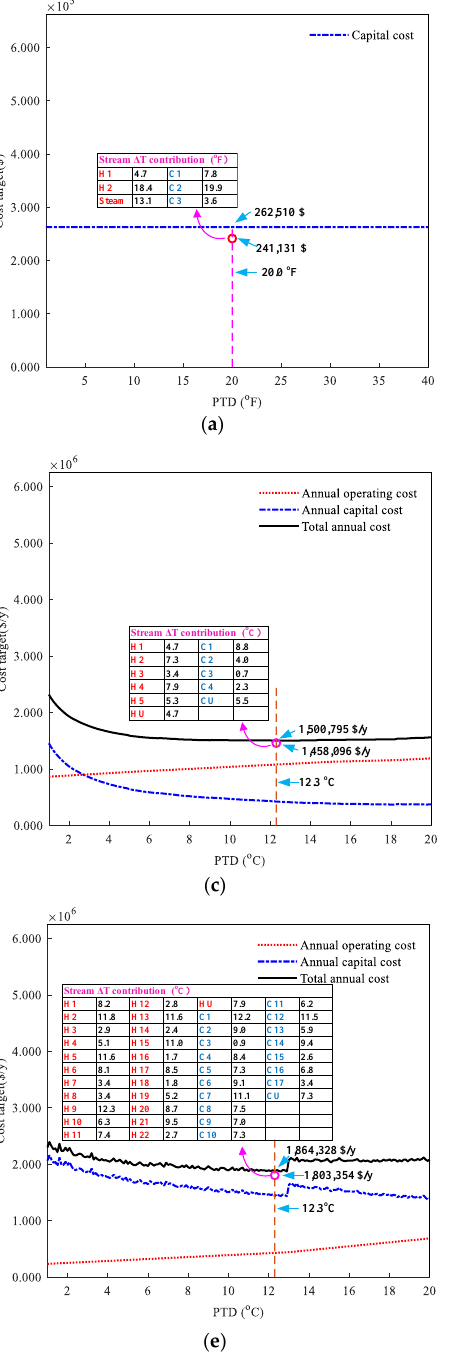
Figure 6. The optimal cost targets of HEN under the uniform and individual TDCs of streams; ( a , b ) contains situations without and with maximum area limitations for case study 1; ( c ) case study 2; ( d ) case study 3; ( e ) case study 4.